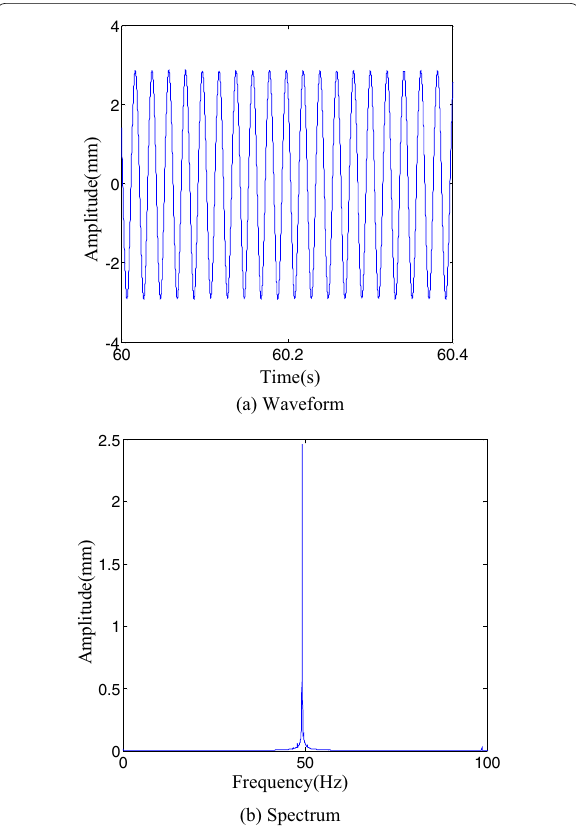
Figure 16 Waveform and spectrum in the x -direction when the disc and the shaft is at the same speed